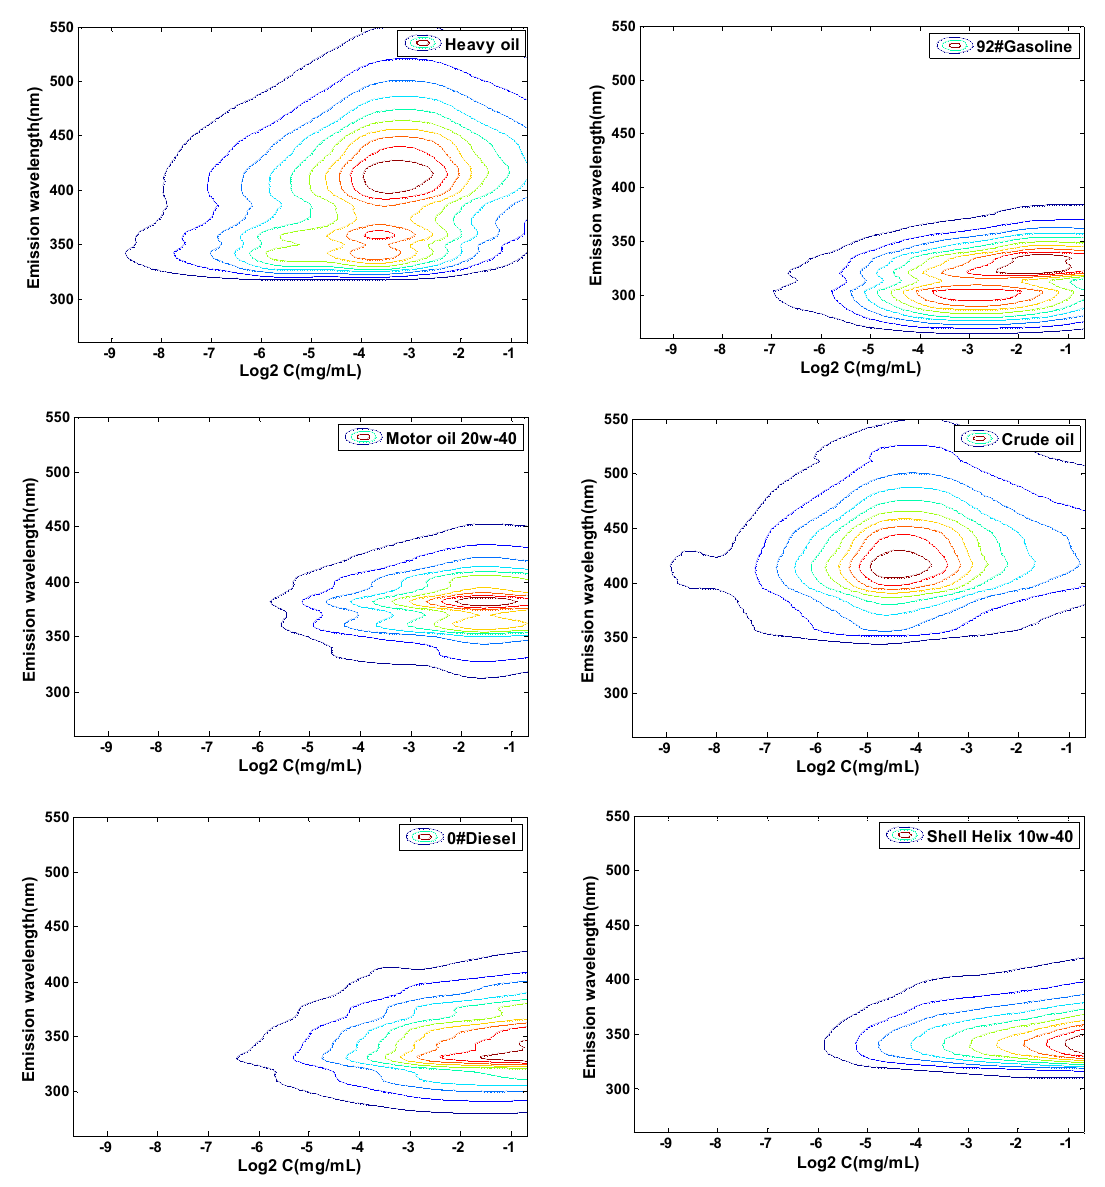
Figure 5. The interpolation CEM spectra of 6 kinds of oil samples.